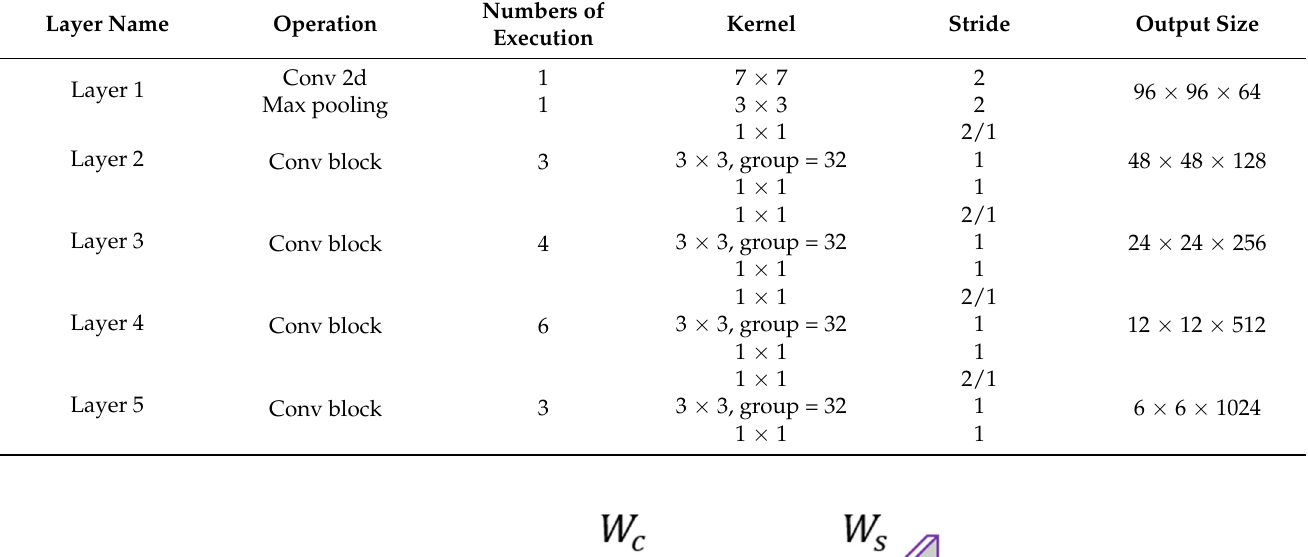
Table 2. Architecture of the main calculations in ResNeXt50.